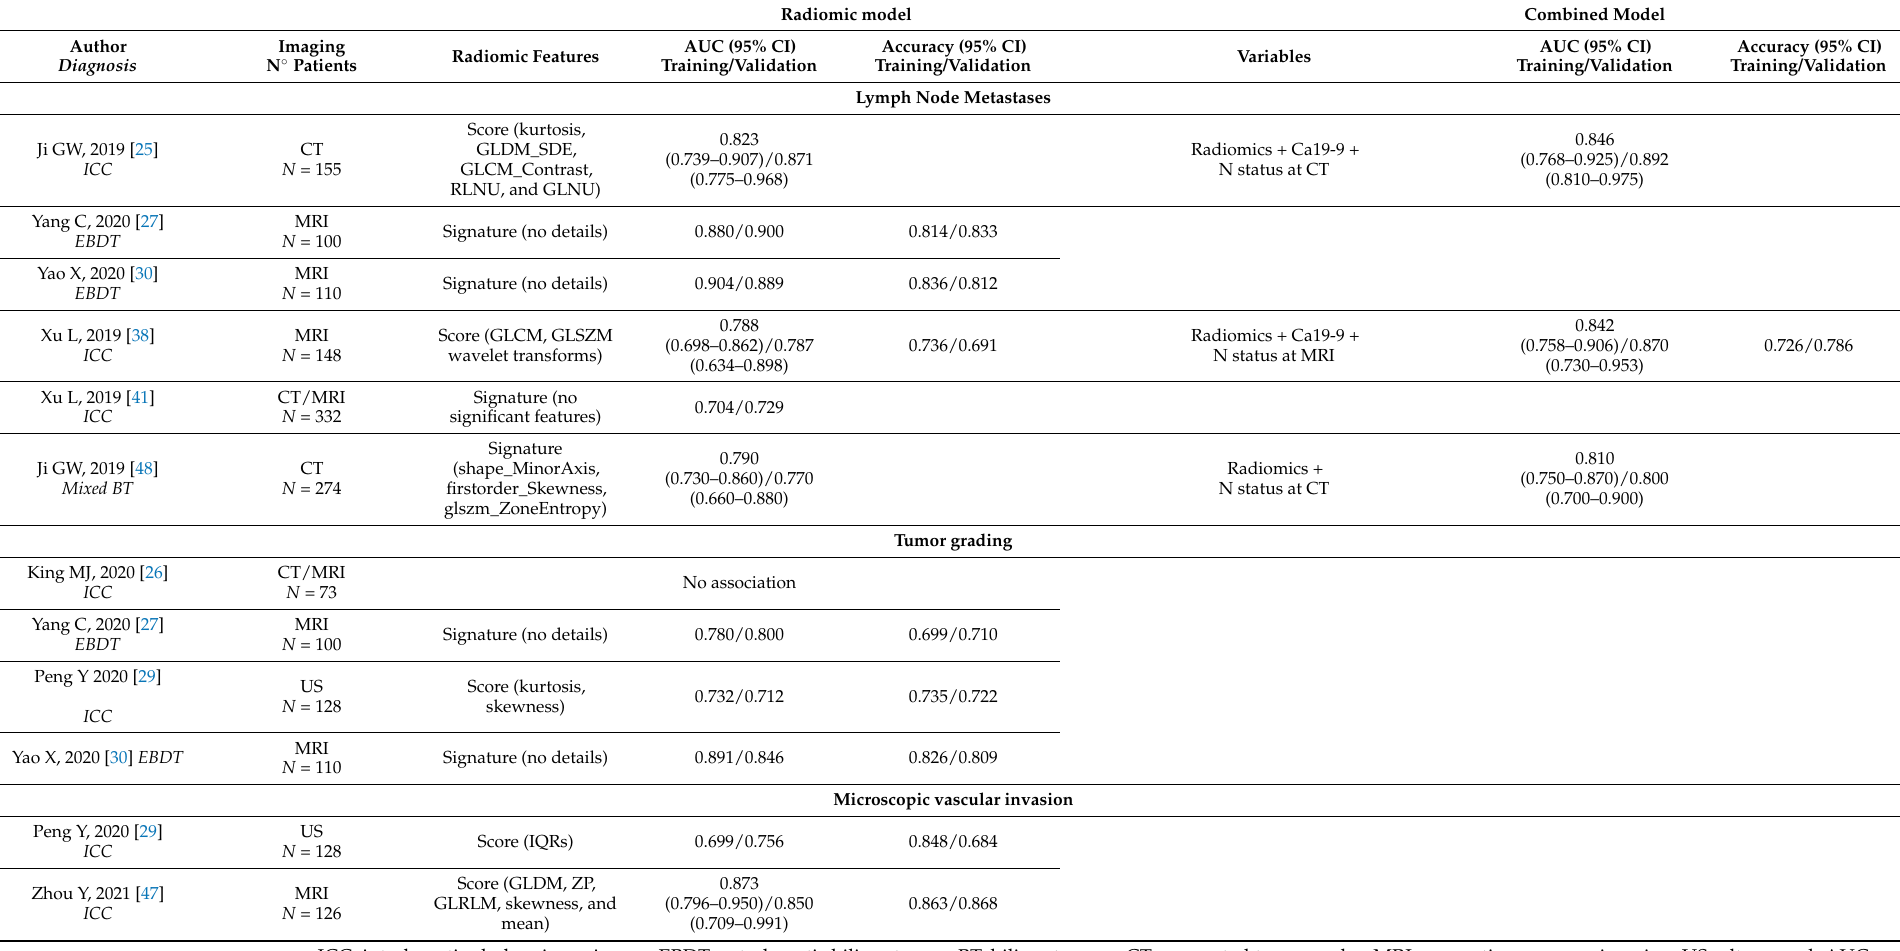
Table 3. Pathology data: lymph node metastases, tumor grading and microscopic vascular